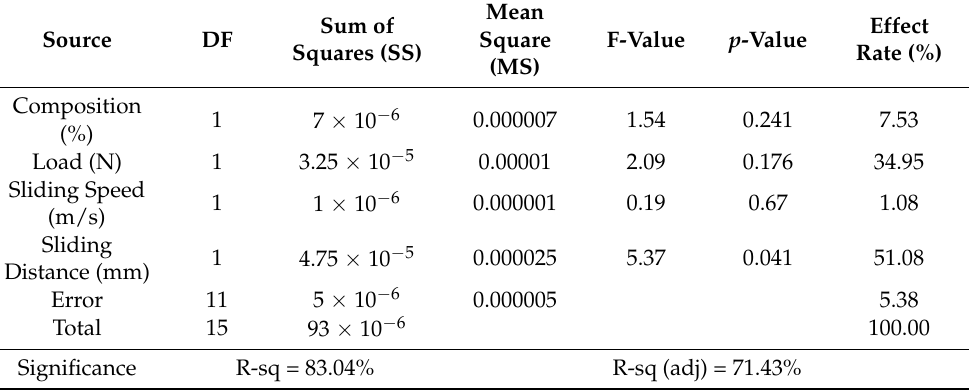
Table 7. ANOVA for specific wear